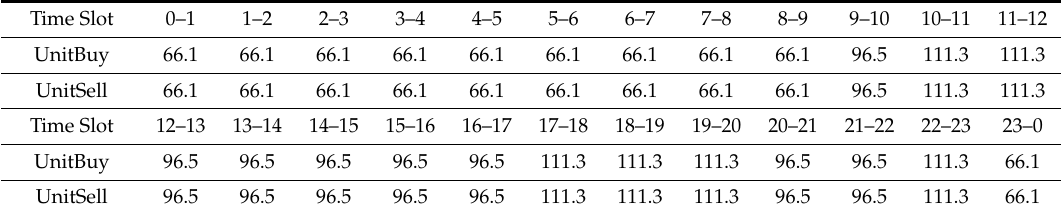
Table 7. The expected power supply unit cost